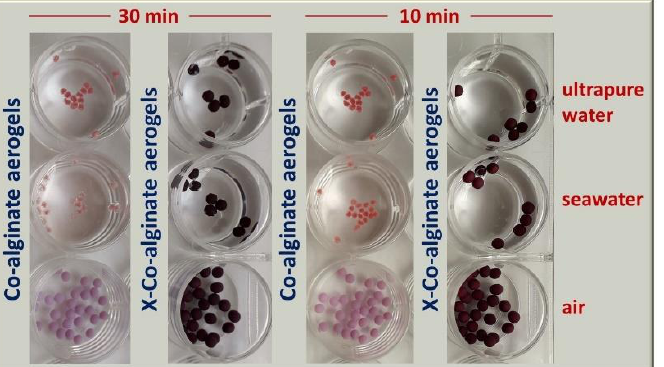
Figure 2. Optical photographs comparing the stability of native M-alginate hydrogels and aerogels and of X-M-alginate aerogels in tap water, seawater, and air. Co II (instead of Ca II ) was used as the gelation cation for alginate because it provides pink materials that increase the imaging contrast.